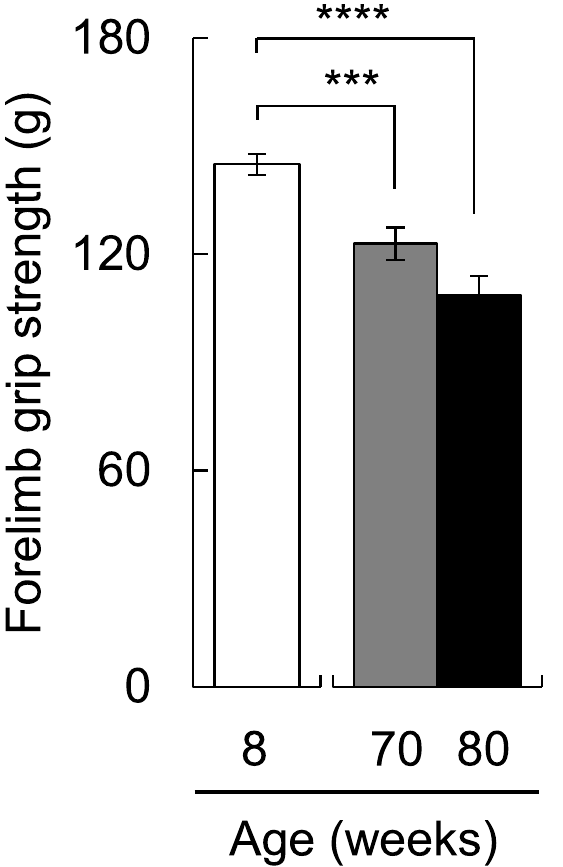
Fig 1. Change of muscle strength due to aging. Forelimb grip strength of 8-week-old (n = 25), 70-week-old (n = 21), and 80-week-old mice (n = 14). Grip strength significantly decreased with age (F ANOVA). ��� p < 0.001 and ���� p < 0.0001 (Tukey posthoc test).